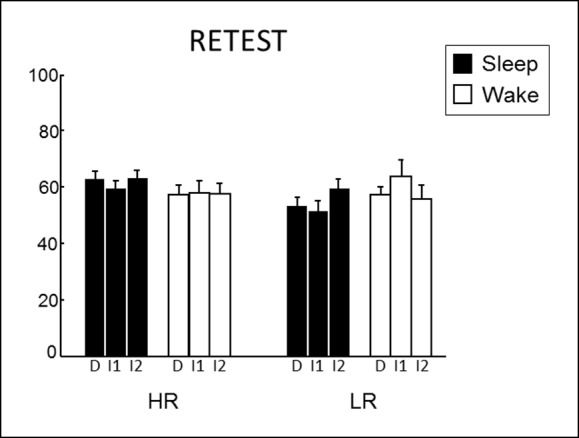
Detailed retest behavioral results.